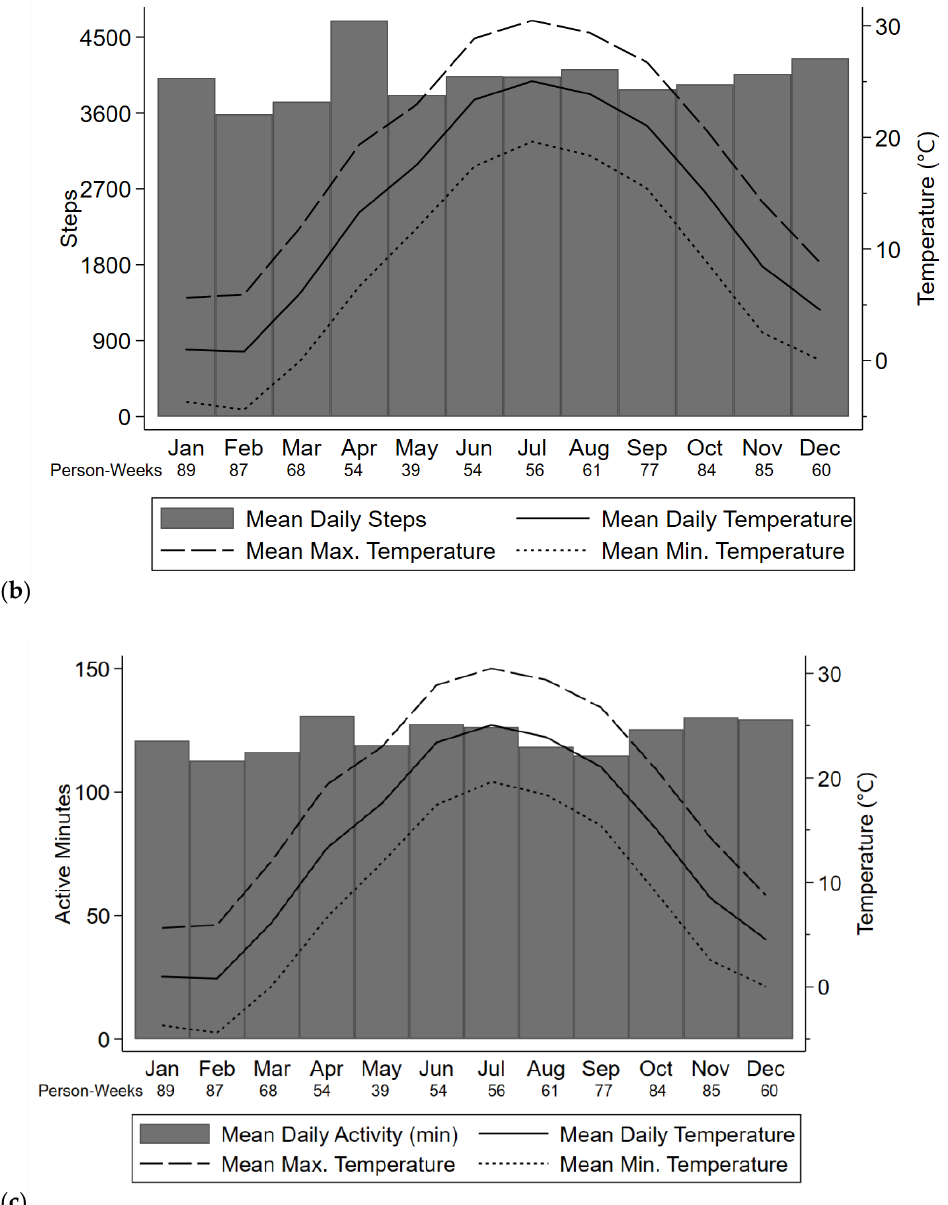
Figure 1. ( a ) Total aggregate falls, ( b ) mean daily steps, and ( c ) mean daily active minutes across all study years and all participants. Daily average, maximum, and minimum temperatures displayed were averaged across all study years. Table 2. Association of weather and season variables with likelihood and location of falls and injurious falls (N = 240) 1 . Likelihood a Fall is Likelihood of Fall Likelihood of Injurious Likelihood of Falling Injurious vs. Non- Occurring Outdoors vs. Fall Occurring Injurious Indoors Outdoors vs. Indoors